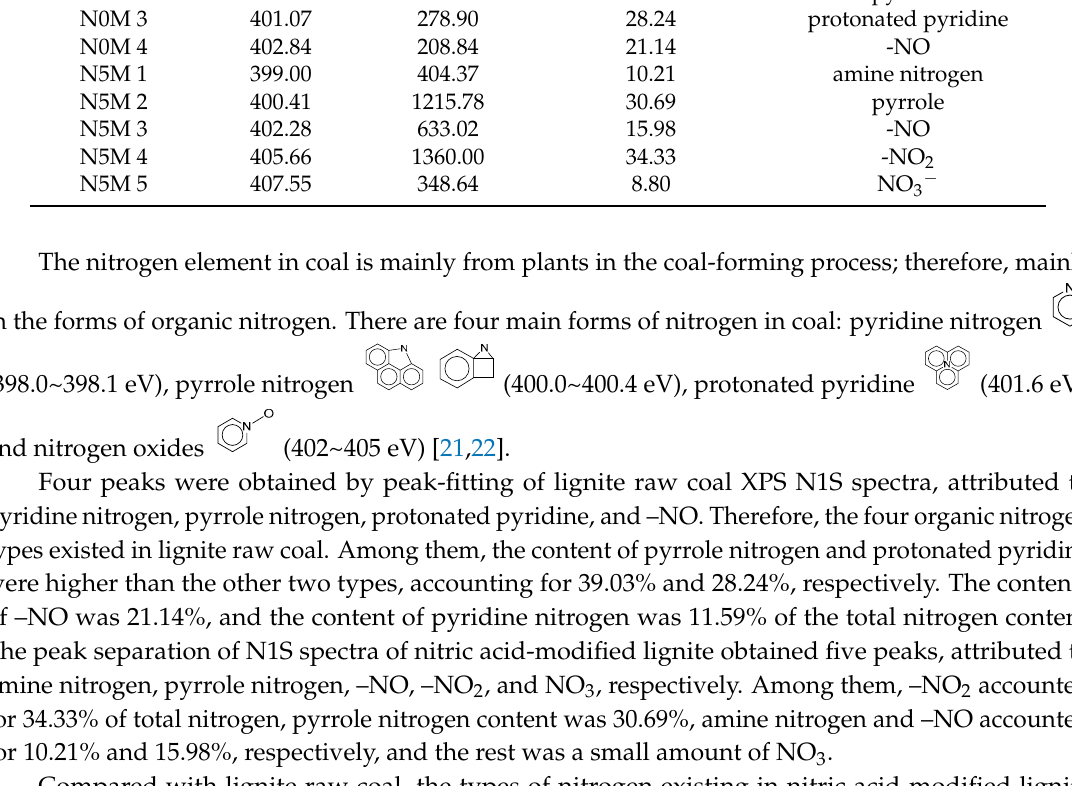
Table 6. XPS N1S peak synthesized data of lignite and nitric acid-modified lignite. Peak Peak Position/eV Area Peak Position/eV Area Relative Content/% Assignment Peak Area